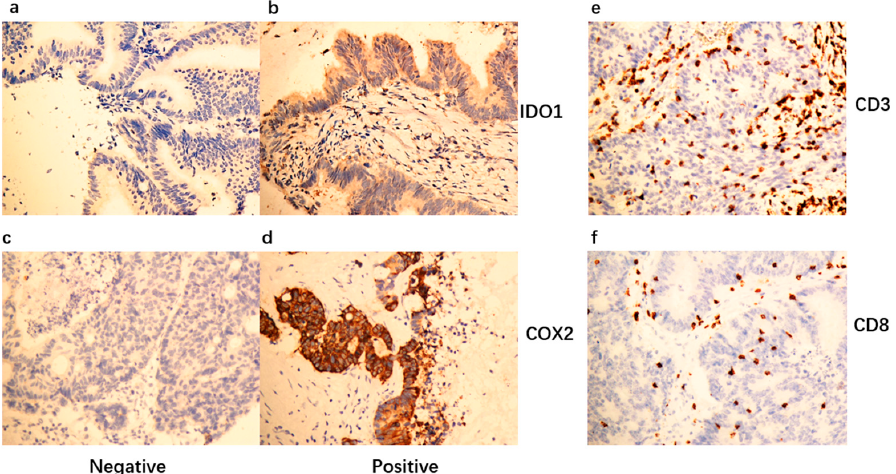
Figure 1. IDO1, COX2, CD3 and CD8 expression levels in CRC patients with liver oligometas- tases. ( a ) Immunohistochemistry (IHC) of negative IDO1 expression in CRC liver oligometastases; ( b ) immunohistochemistry (IHC) of positive IDO1 expression in CRC patients with liver oligometas- tases; ( c ) immunohistochemistry (IHC) of negative COX2 expression in CRC liver oligometastases; ( d ) immunohistochemistry (IHC) of positive COX2 expression in CRC liver oligometastases; ( e ) im- munohistochemistry (IHC) of positive CD3 expression in CRC liver oligometastases; ( f ) immunohis- tochemistry (IHC) of positive CD8 expression in CRC liver oligometastases.